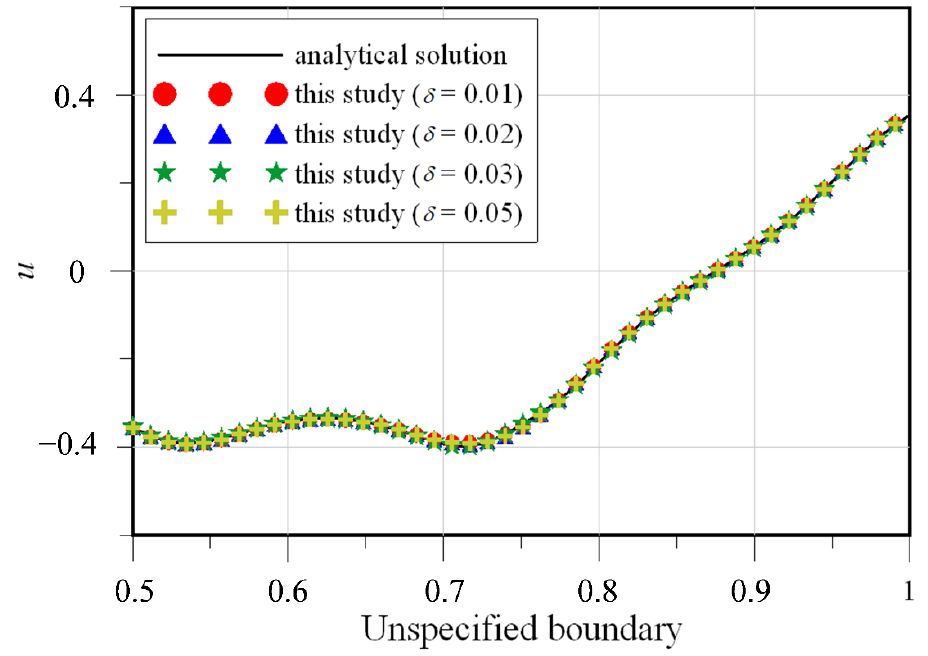
Figure 19. Comparison of the results for Example 3.